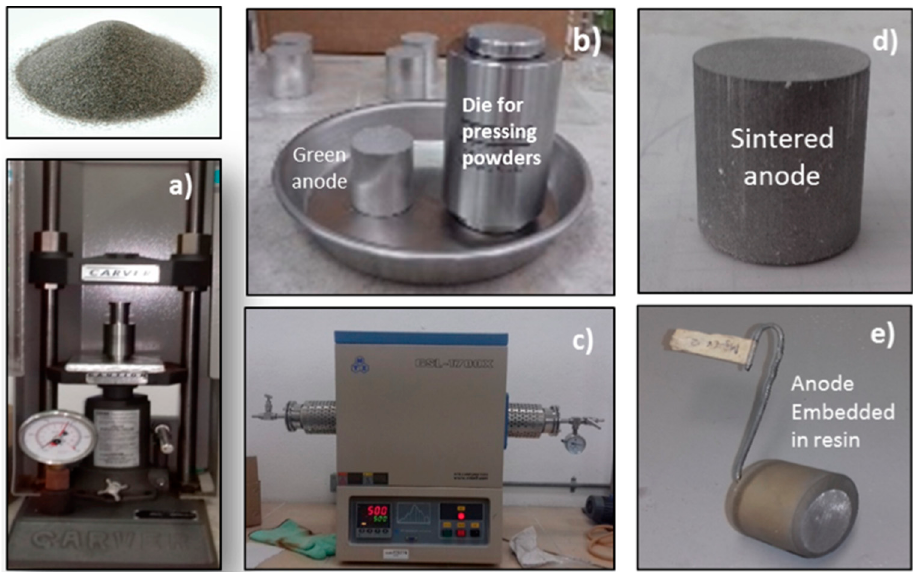
Figure 2. Anode manufacturing process, ( a ) powder compaction, ( b ) green anodes obtained, ( c ) sintering of anodes at 500 °C, ( d ) sintered anode, ( e ) anode encapsulation.